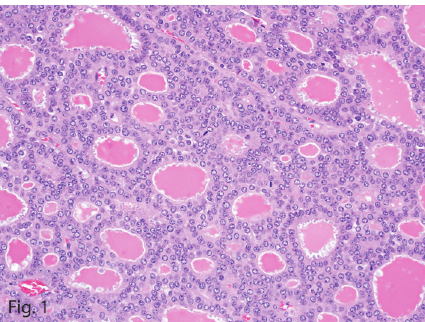
Figure 1: Hepatic tumor with multiple acinar-like structures. These structures contain eosinophilic secretions (thyroid-like morpho- logic characteristic) with brisk mitotic figures and neoplastic cells with “salt and pepper” chromatin (hematoxylin-eosin, original magnification × 40).